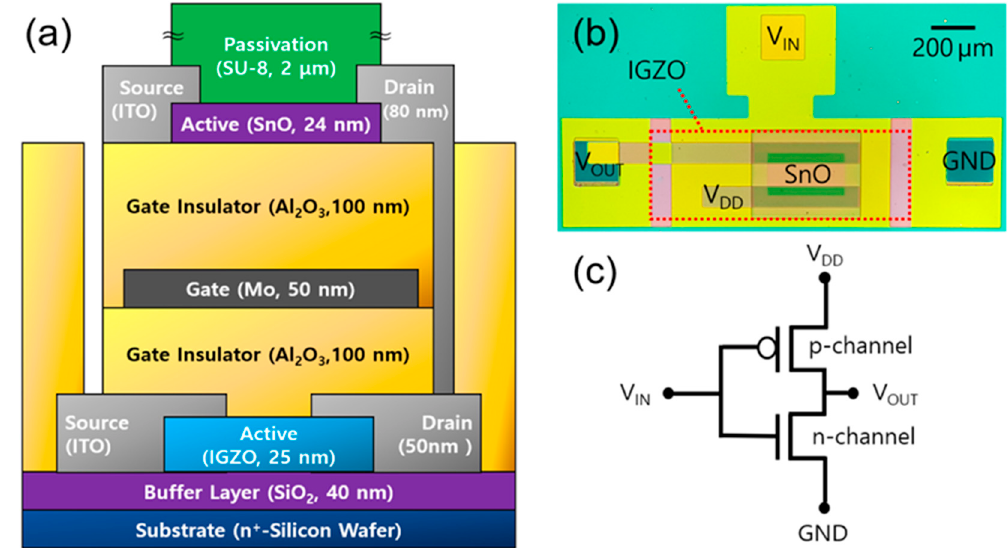
Figure 1. ( a ) schematic cross-sectional view, ( b ) optical image, and ( c ) circuit diagram of the vertically stacked complementary logic inverter composed of p-type tin monoxide (SnO) and n-type indium-gallium-zinc oxide (IGZO) thin-film transistors (TFTs).